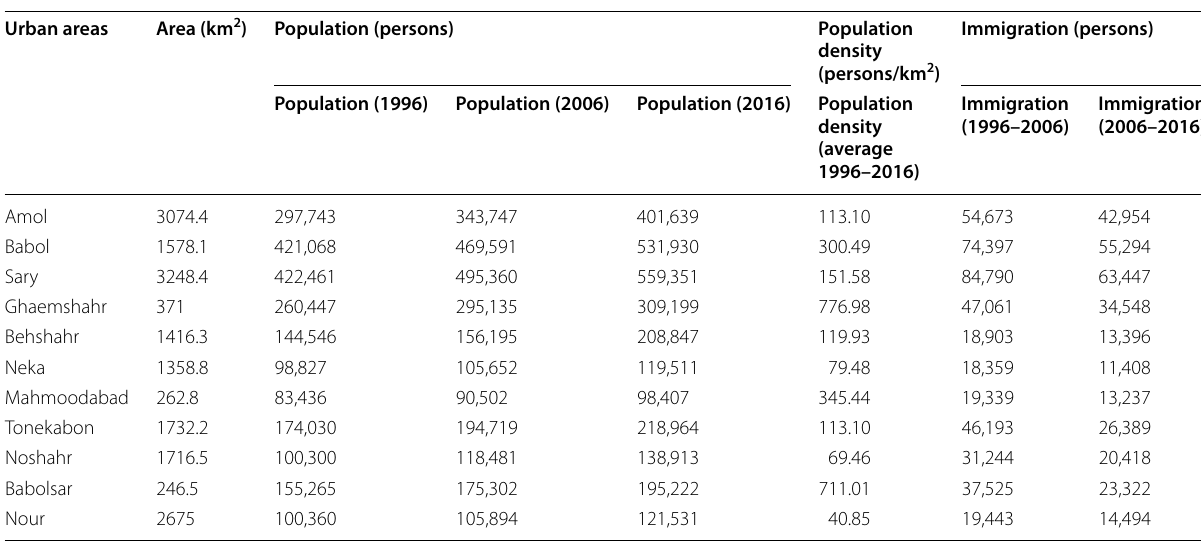
Table 1 General characteristics of the selected urban areas